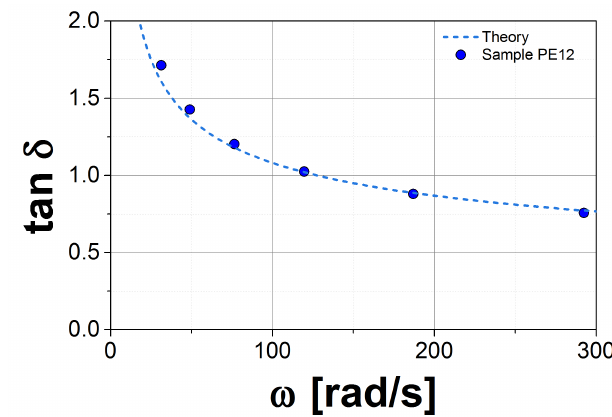
Figure 2. Comparison between the tan ( δ ) for experiments (symbols) and theory (dashed lines) for the sample